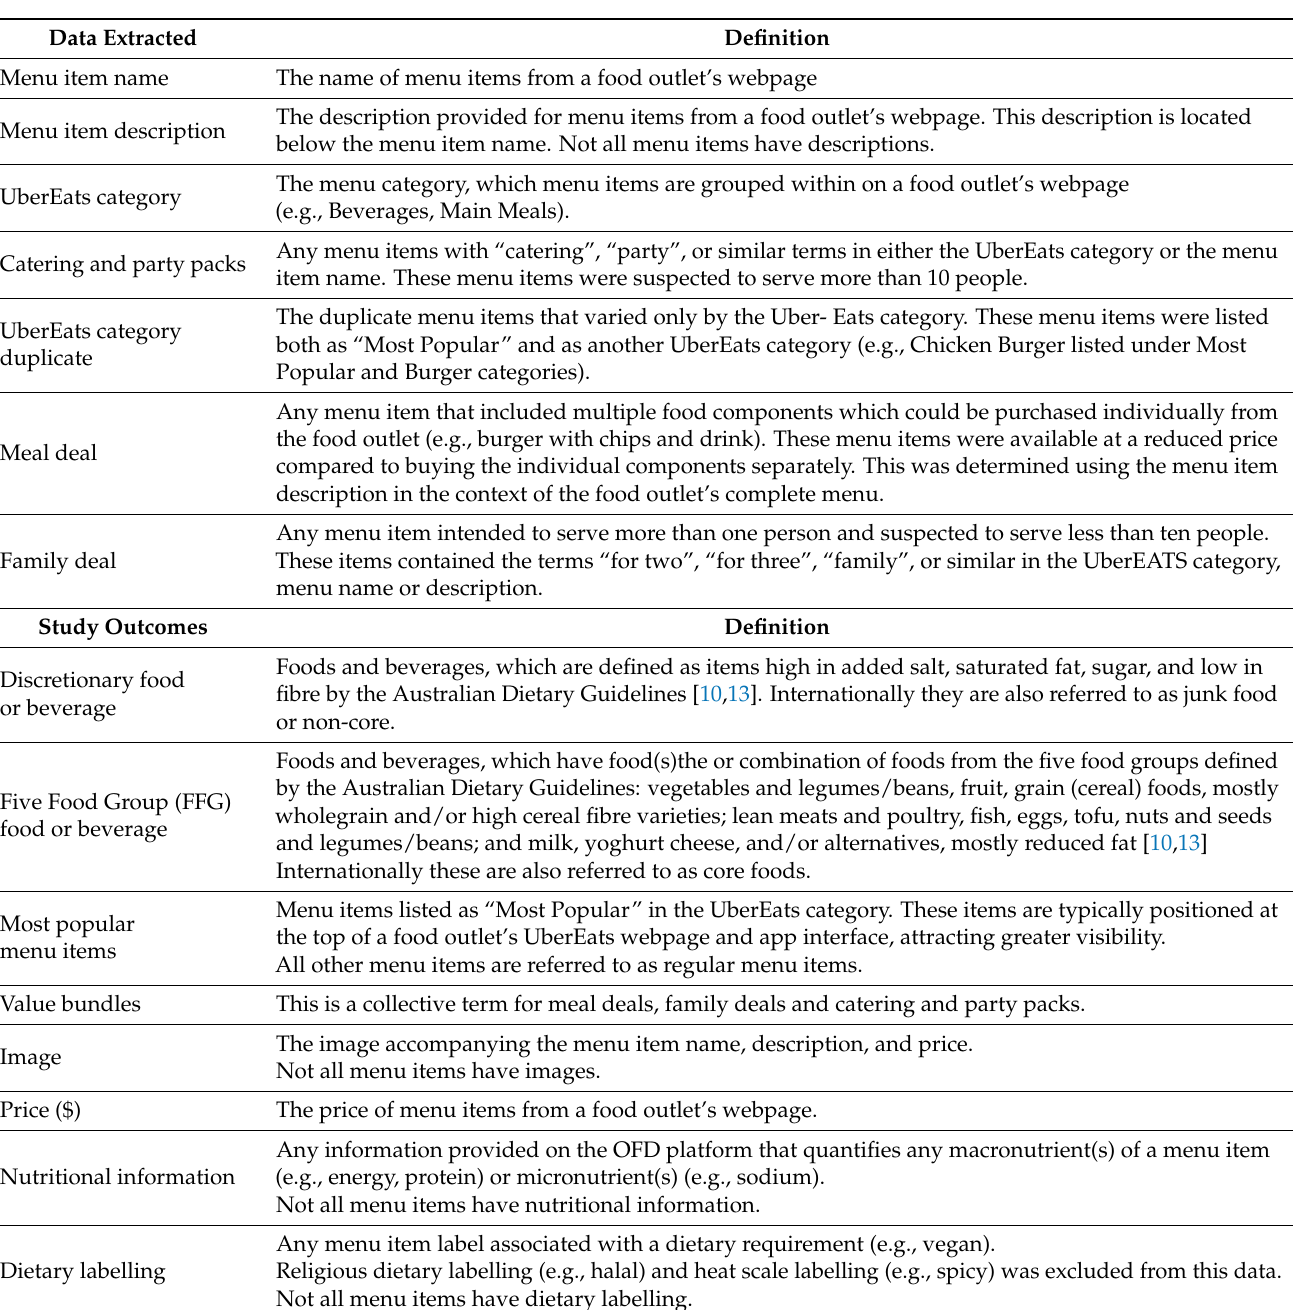
Table 1. Summary of definitions and derivations of data extracted from complete menus of each independent takeaway and study